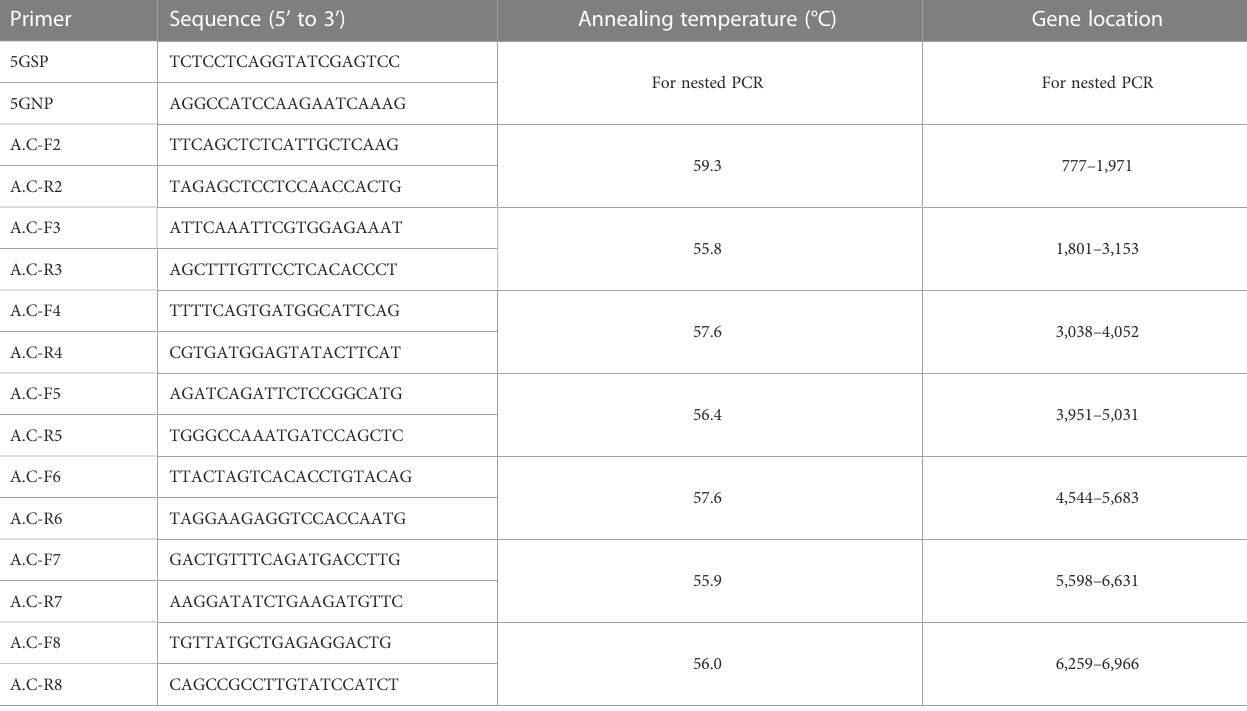
TABLE 2 PCR primers used to amplify ACCase cDNA of D . ciliaris var. chrysoblephara. Primer Sequence (5 ’ to 3 ’